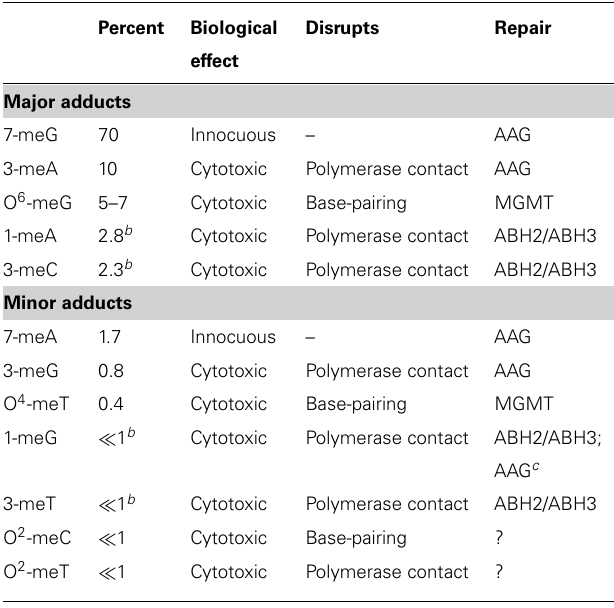
Table 1 | Base adducts produced by S N 1 methylating agents a